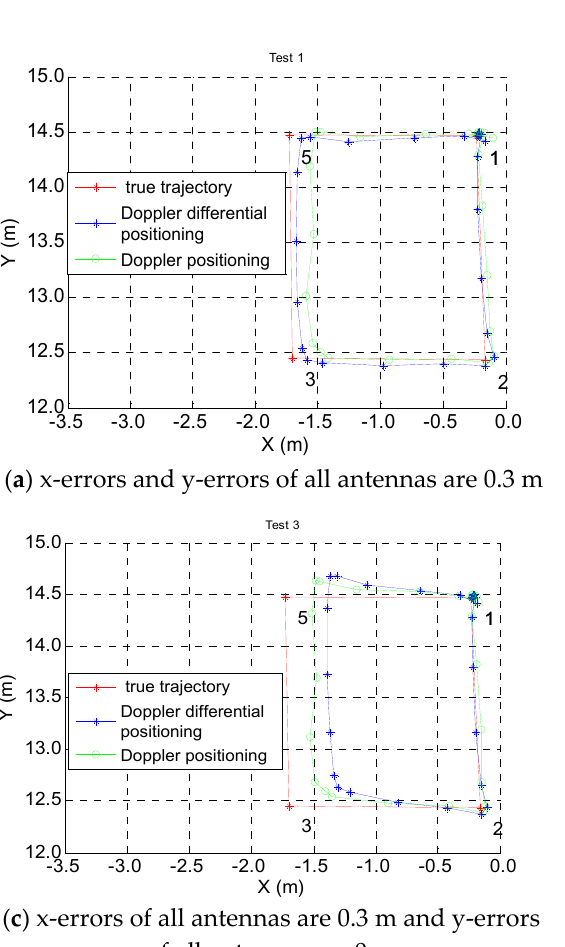
Figure 11. Horizontal dilution of precision (HDOP) on a straight-line trajectory.